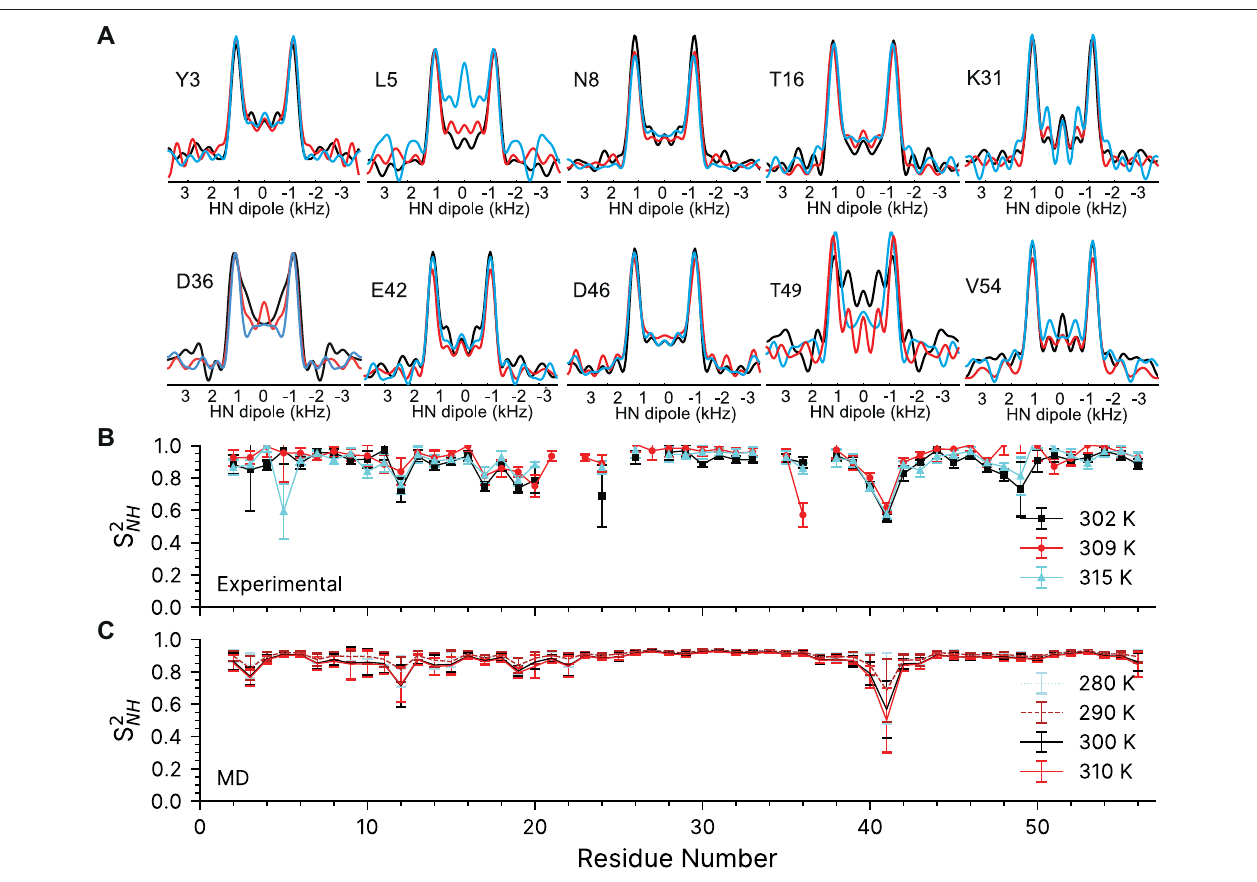
FIGURE 5 | 15 N- 1 H dipolar couplings as a function of temperature in crystalline GB1. (A) Representative dipole-dipole recoupling spectra using the R14 85 (115 (0) ,295 (180) )pulsesequenceat ∼ 302 K, ∼ 309and ∼ 315 Kat60 kHzspinning. (B) S 2 NH obtainedfromthemeasureddipolar couplings,errorbarsaredrawnat1 σ . (C) S 2 NH obtainedfromvariabletemperaturemoleculardynamicssimulations.MDderivedorderparameterswereextractedfrom400 nsmoleculardynamicssimulationsofa 3 × 3 × 3 supercell of GB1 containing 108